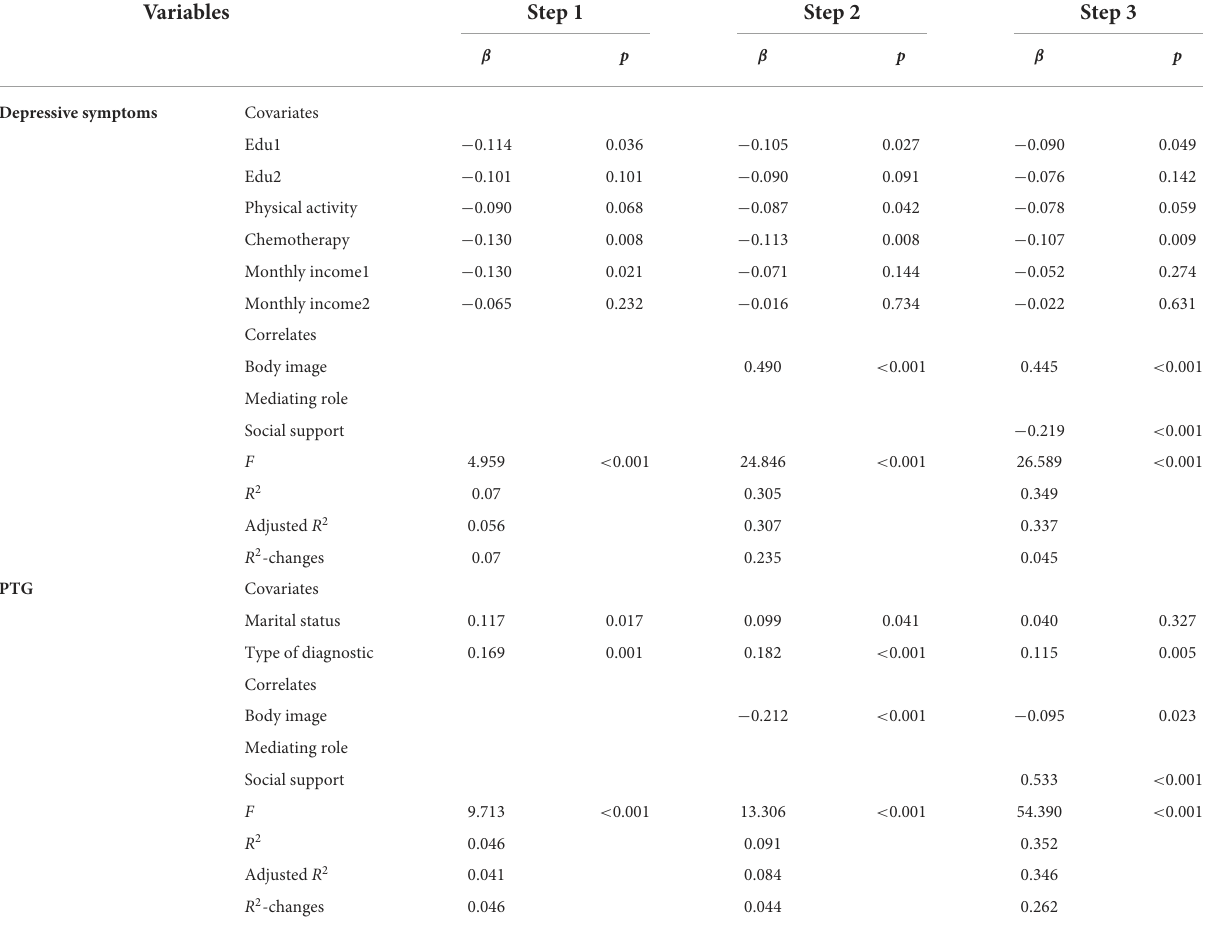
TABLE 3 Associations of body image and social support with depressive symptoms and PTG.